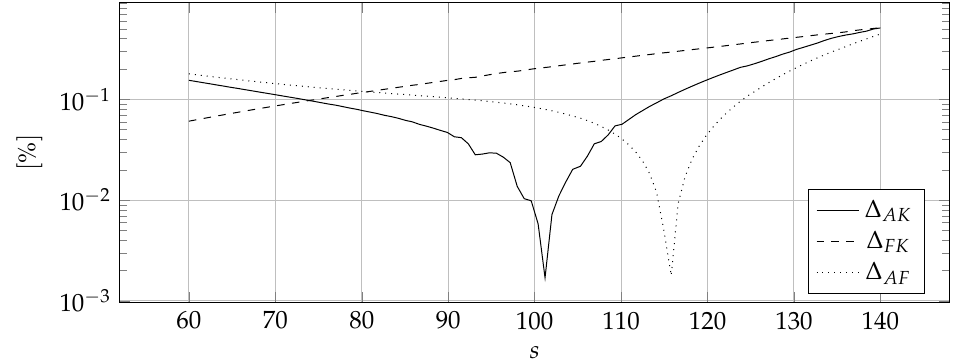
Figure 9. The influence of the sharpness parameter s on the ∆ AK , ∆ FK , and ∆ AF error measures for 100 collocation points.